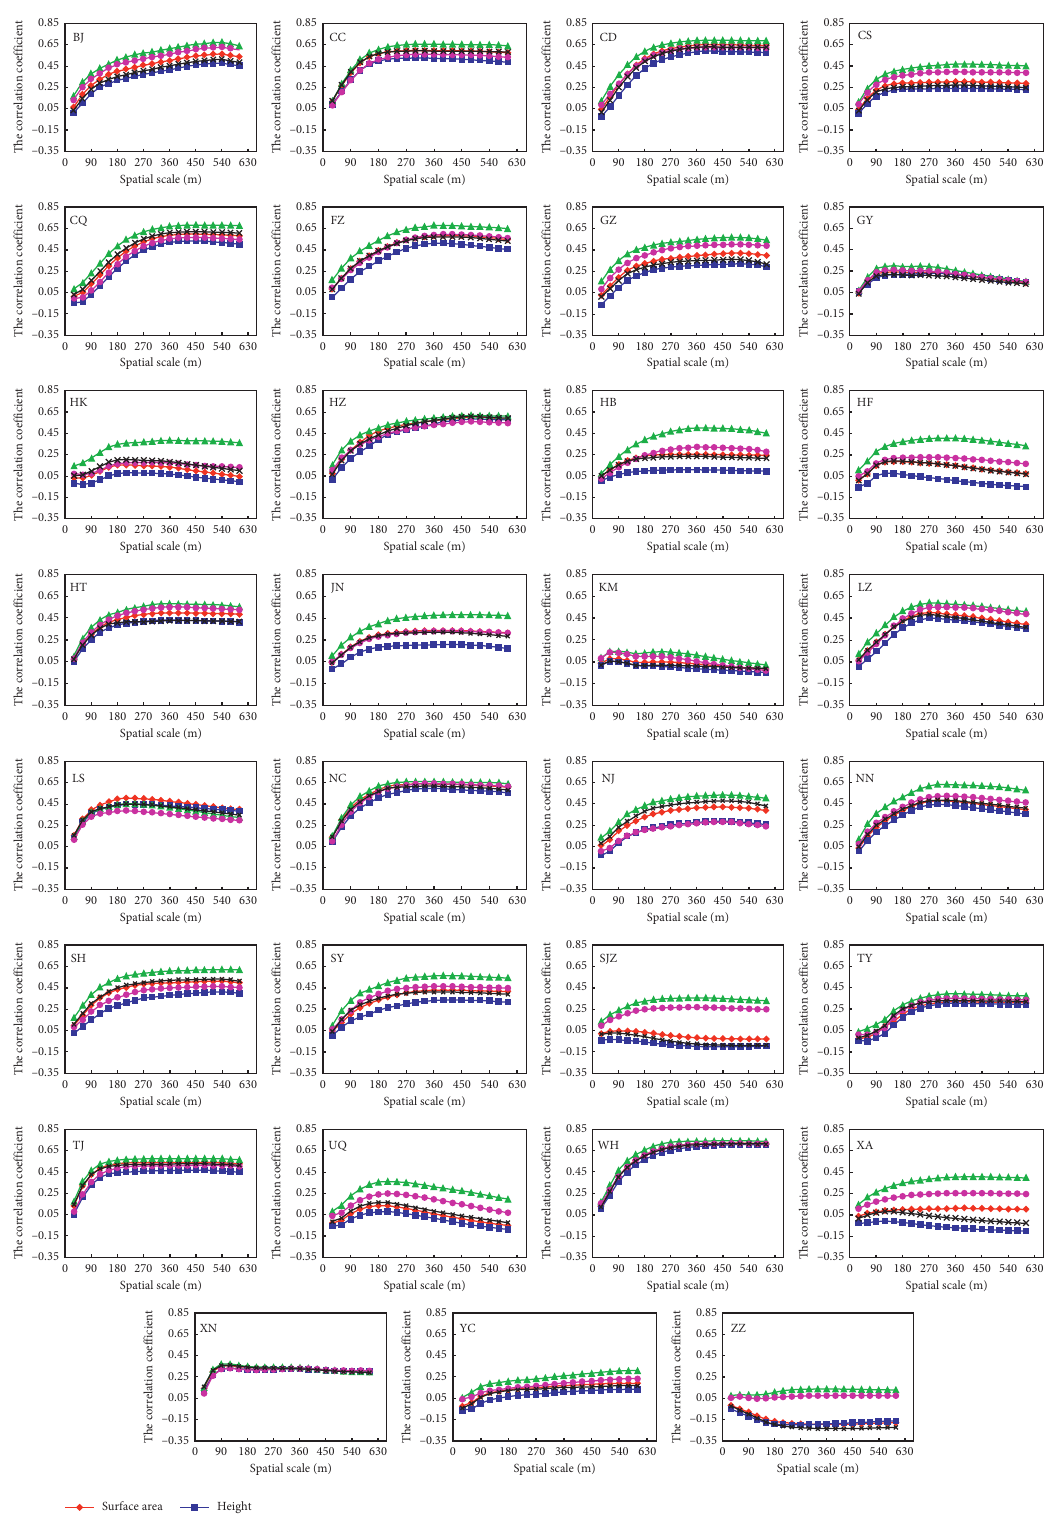
Figure 4: Pearson correlation coefficients between 3D building morphology parameters and the relative UHI intensity at different spatial